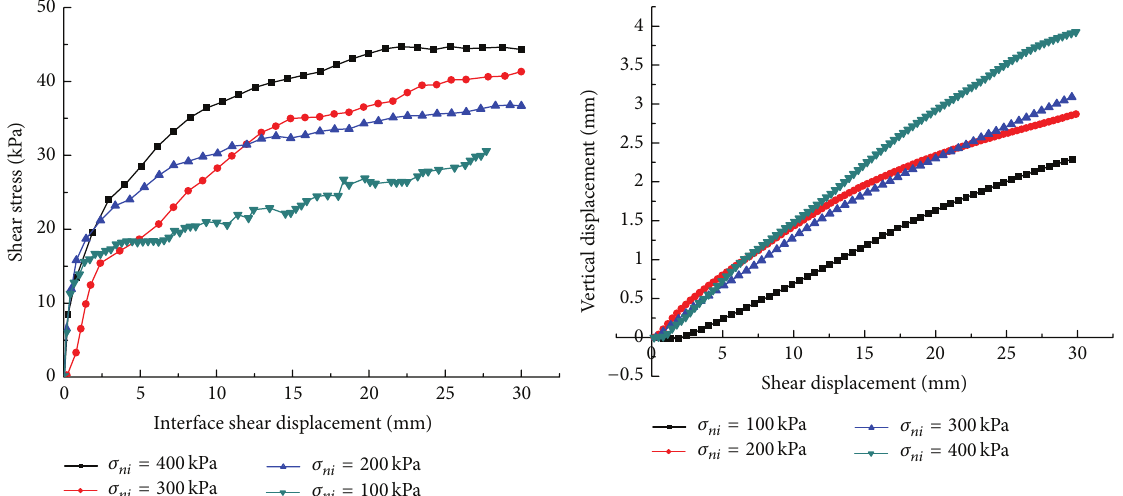
Figure 8: Test results for the interface between plate #2 and clay (applied normal stress of